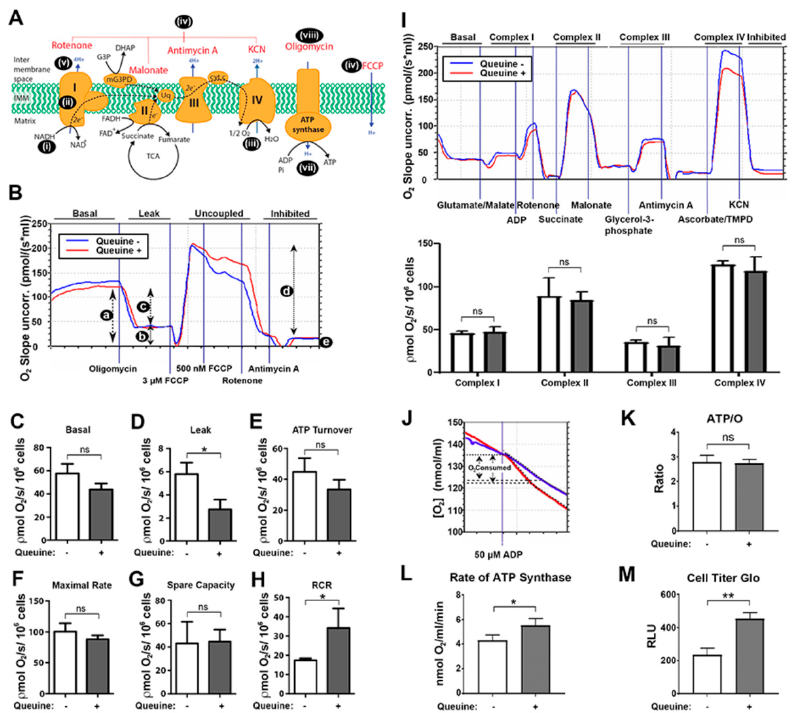
Figure 3. Electron transport chain (ETC) activity is normal in queuine deficiency whereas leak and ATP synthesis are a ff ected. ( A ) Mechanism and inhibition of the electron transport chain (ETC). The ETC ( i ) acquires free energy from food substrates (glucose, amino acids, fatty acids) through the intermediacy of NADH cofactor, succinate, and glycerol-3-phosphate (also fatty acids; not shown). Electrons flow stepwise ( ii ) through a chain of carrier complexes I-IV, situated in the mitochondrial inner membrane, with oxygen (O 2 ) acting as the terminal electron acceptor ( iii ), which is reduced to water. Electron flow can be interrupted at each complex using specific inhibitors ( iv ), as shown. Electron movement along the ETC is coupled to proton translocation from the mitochondrial matrix into the intermembrane space ( v ) creating a protomotive force across the inner membrane, which can be artificially dissipated by the ionophore FCCP ( vi ). The flow of protons back across the membrane through the ATP synthase (complex V) drives ATP synthesis ( vii ) from ADP and inorganic phosphate (Pi). The activity of the ATP synthase in both forward and reverse directions can be inhibited by oligomycin (viii). ( B ) HeLa cells were cultured in the absence (blue lines) or presence (red lines) of 1 µ M queuine for 48 h, harvested, resuspended in MiR05 bu ff er, and 4 × 10 6 cells were introduced into each chamber of an Oroboros oxygraph-2K instrument. The parameters a. basal respiration, b. oligomycin-insensitive respiration (leak; state 4o), c. oligomycin-sensitive (ATP turnover) respiration, d. maximum respiratory capacity in the presence of FCCP (state 3u), and e. the non-mitochondrial respiration rate were determined (representative trace) by the addition of the indicated agents (top figure). ( C ) Basal, ( D ) leak, ( E ) ATP turnover, ( F ) maximal / uncoupled rate, ( G ) spare capacity, and ( H ) respiratory control ratio (RCR) are graphed from repeat experiments. ( I ) Respirometric analysis of the ETC. After endogenous respiration had stabilized, glutamate and malate were added as substrate for complex I, cells were permeabilized with digitonin and respiration stimulated with the addition of ADP (upper panel; representative trace). Subsequently, the indicated substrates and inhibitors were added to examine the activity of complexes I–IV. Data from repeat experiments were graphed (lower panel). ( J ) The ATP / O ratio was measured using the NADH-linked substrates glutamate and malate (representative trace). Cells were permeabilized with digitonin and adenylate kinase inhibitor Ap5A added to each chamber. Once a stable rate of respiration was established a fixed concentration of ADP (50 µ M) was added, the O 2 consumption recorded and the ATP / O ratio ( K ) and rate of ATP synthesis ( L ) calculated. ( M ) The level of cellular ATP was measured using CellTiter-Glo reagent. Graphed data represent mean ( ± s.d.) for triplicate samples. n = 3. * p < 0.05, ** p < 0.01, ns, not-significant, t